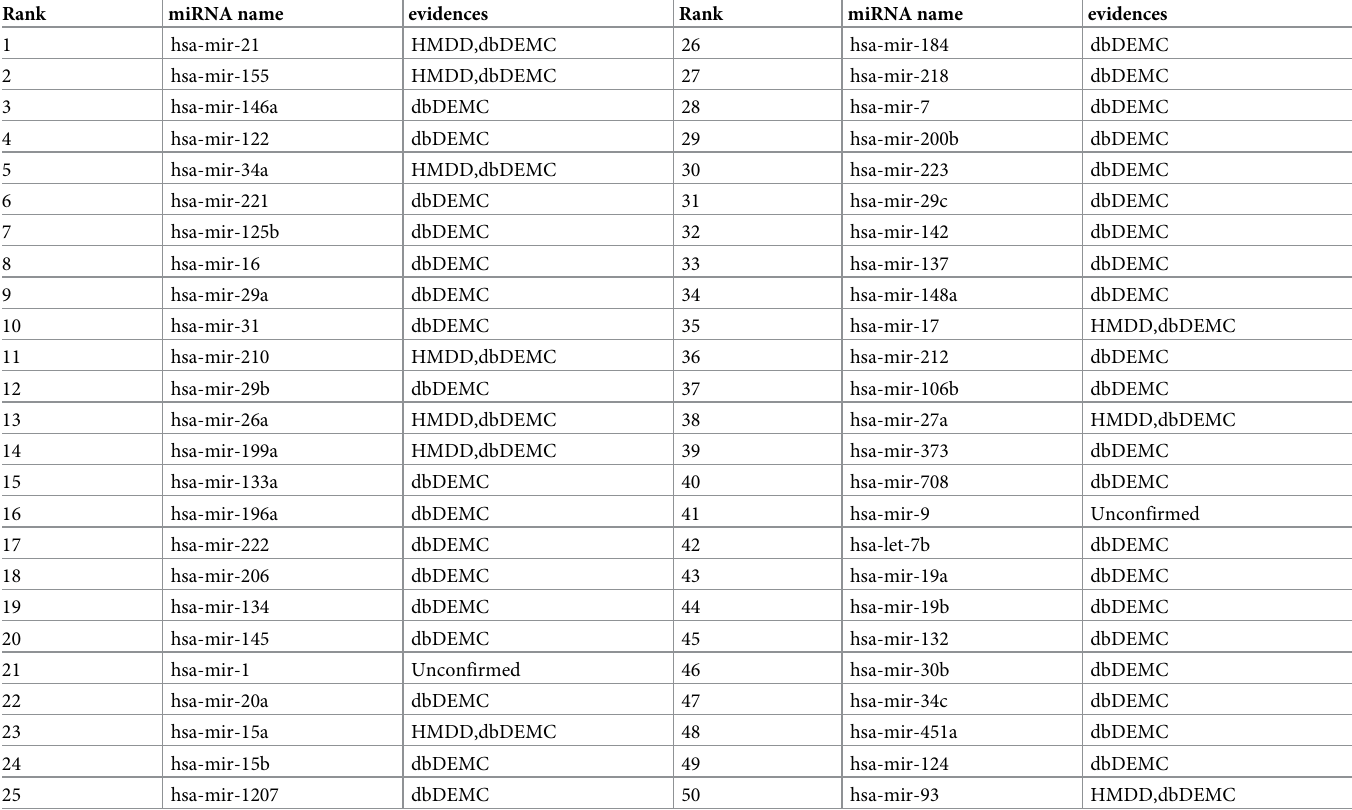
Table 4. The top 50 kidney neoplasms–related miRNAs candidates predicted by NPRWR with removed all known kidney neoplasms–miRNAs associations and the confirmation of these